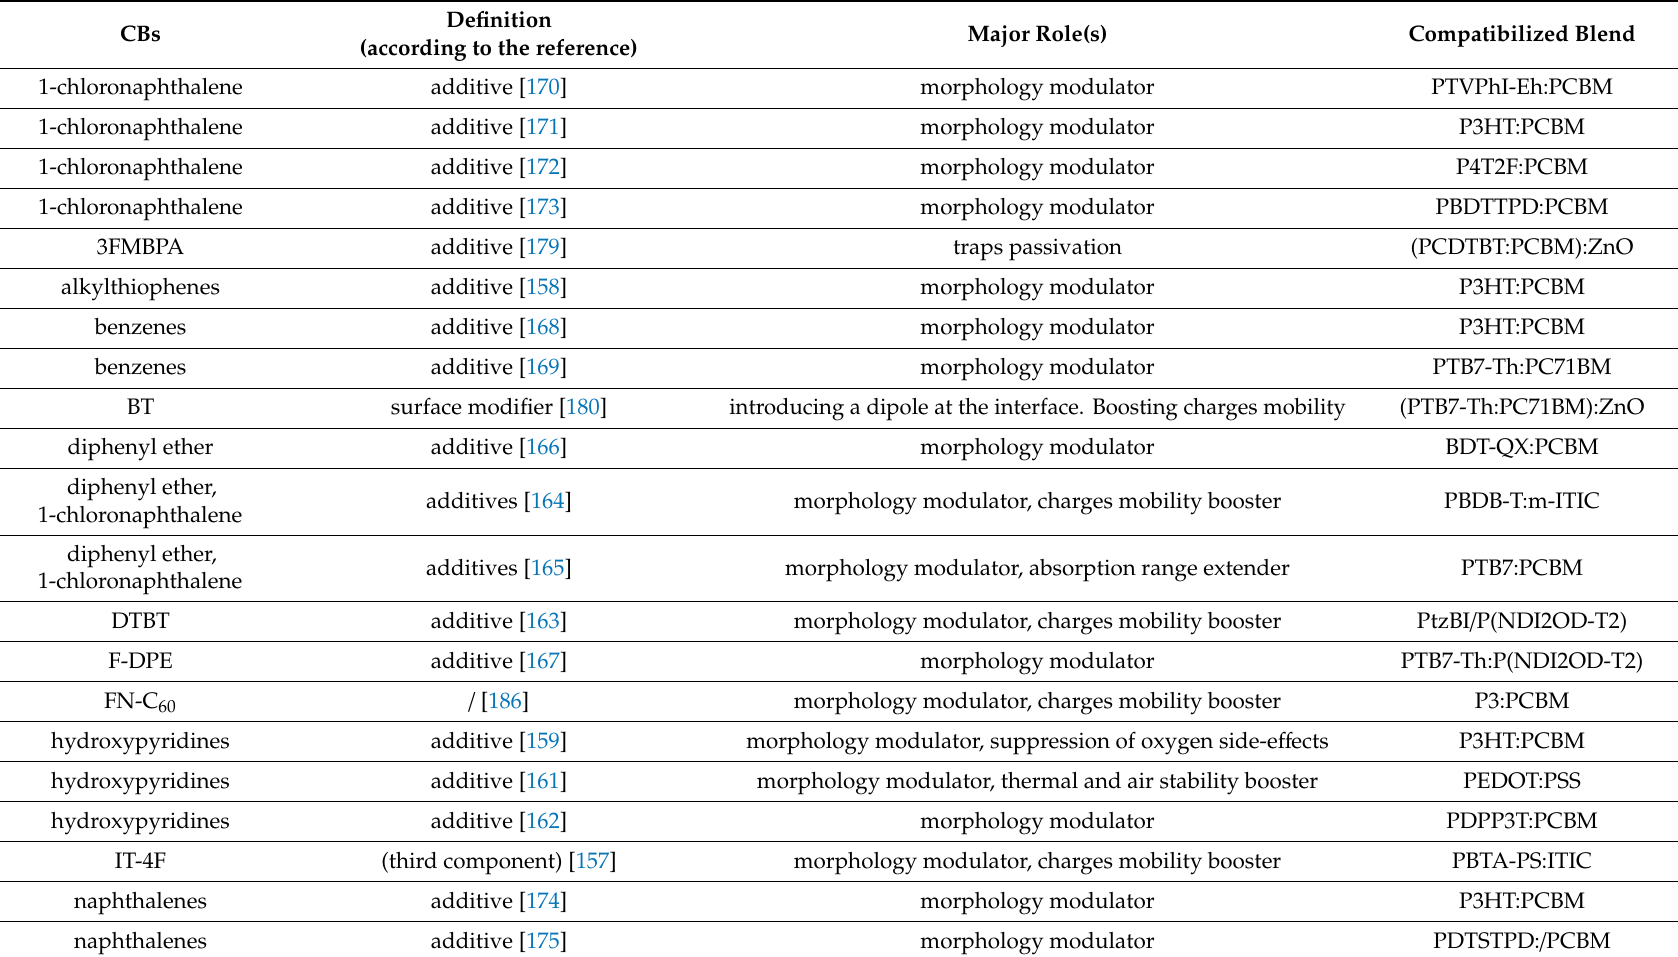
Table 2. A summary of the small-molecule-based CBs, including the nomenclature provided in the reference articles, the major role(s) played in the device, and the compatibilized blend. CBs are reported according to the label provided by the authors in the cited article and reported by us in Figure